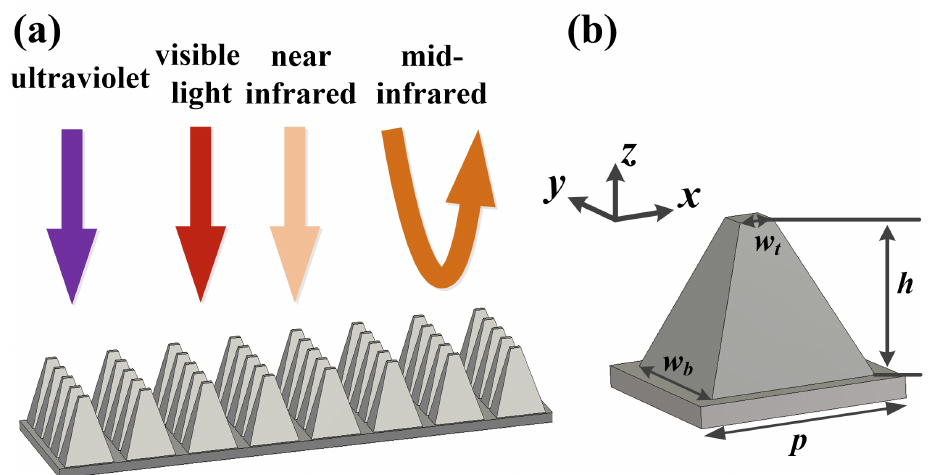
Figure 1. The schematic diagram of the refractory all-metal metamaterial selective absorber: ( a ) Three dimensional schematic of the MMA, ( b ) the schematic of the unit cell